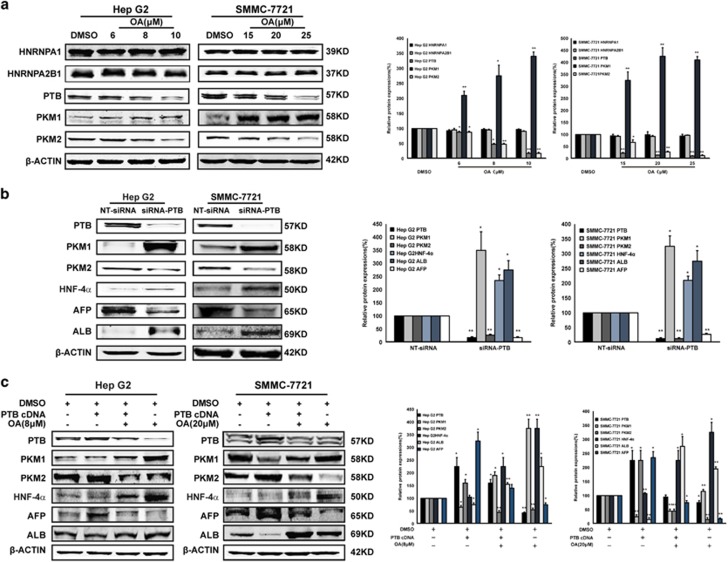
OA decreased the expression of PTB, leading to a high PKM1/PKM2 ratio. (a) WB of PTB, hnRNPA1, hnRNPA2, PKM2, PKM1 and β-actin (a loading control). (b) WB of PTB, HNF-4α, PKM1, PKM2, ALB and AFP from HepG2 and SMMC-7721 cells transfected with none-targeted siRNA(NT-siRNA) and siRNA-PTB. (c) Cells transfected with PTB-expressing vector were treated with OA or vehicle for 72 h and collected for WB. Bars, SD. *P<0.05 or **P<0.01 versus DMSO-treated cells